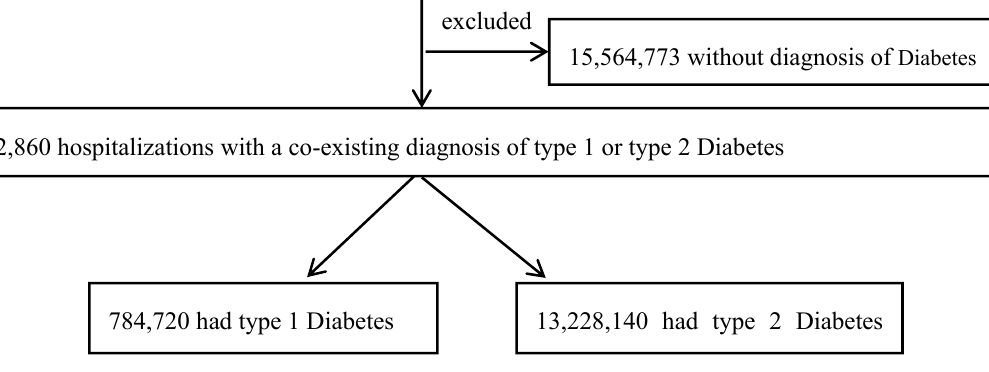
Figure 1. Flowchart describing identification of the study cohort.